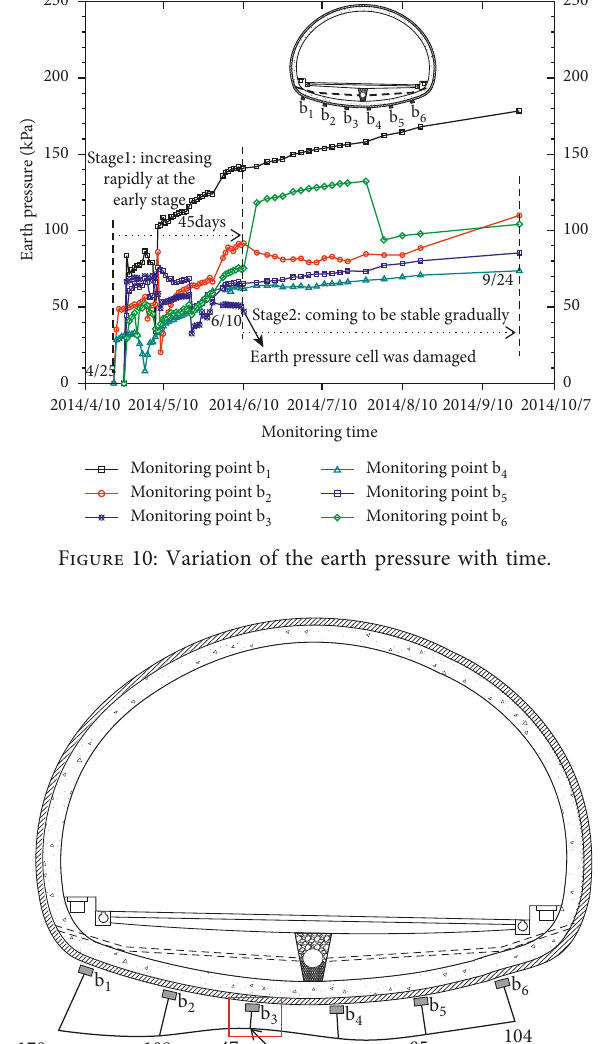
Figure 9: Distribution of the stress on pile tops (kPa).